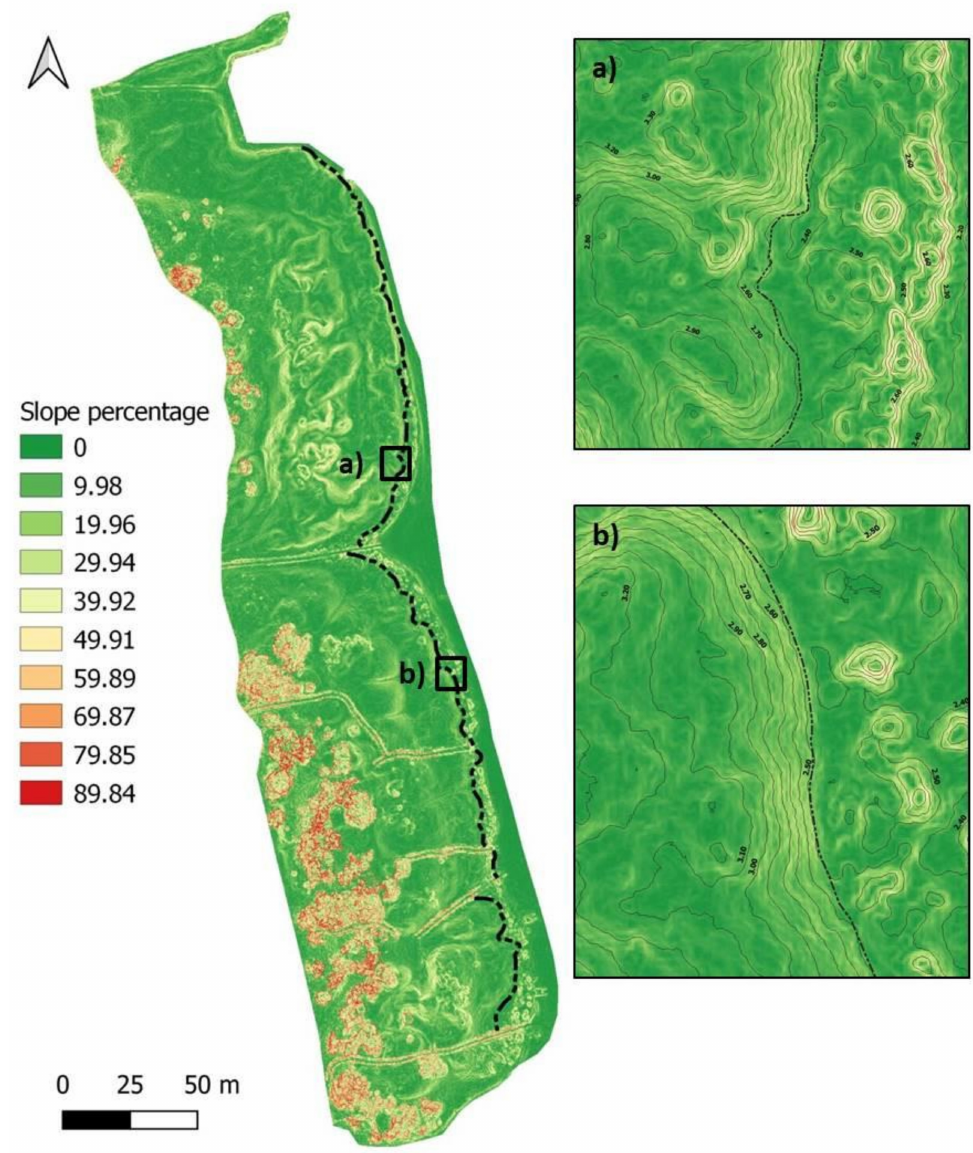
Figure 4. The dune foot line (DFL) identification based on surfaces slope; ( a , b ) boxes: enlarged view of the overlapped elevation contour lines to the slope model, to more exactly identify the dune foot